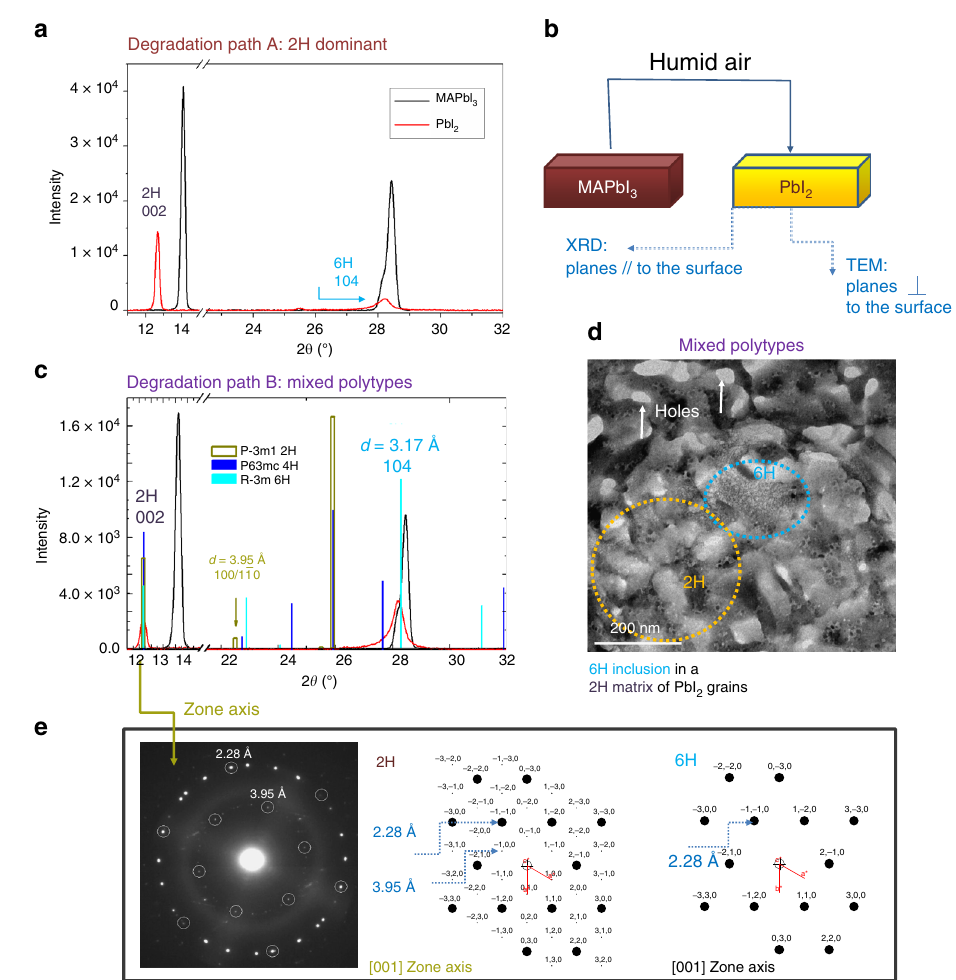
Fig. 6 Large area statistics by XRD on PbI 2 after full in air degradation of MAPbI 3 layers deposited on glass. a – c 2 θ – Ω symmetric X-ray diffraction patterns of fresh MAPbI 3 (black curves) layers fully converted into PbI 2 (red curves) under humid air conditions. In the statistics, the two degradation paths (A and B) represent possible scenarios for sample aged in air. Path A is the more frequently encountered. Path B is less frequent and represents a bridge toward the TEM-induced degradation. The vertical bars in c , that can be equally used for interpretation of the peaks in a , are markers for the different PbI 2 polymorphisms: light brown, blue and light blue lines stem for 2, 4, and 6H polytypes. Probed area = 0.2 cm 2 . b Schematic of the experiment that combines TEM and XRD analyses to study parallel and perpendicular planes with respect to the sample surface. d BF-TEM analyses of an in air degraded sample on the Cu-grid, showing the inclusion of a 6H-PbI 2 grain (light blue circle) morphologically and structurally different from the rest of the matrix (integration time = 4 s). The dominance of the 2H arrangement is drawn on the basis of the speci fi c spot at 3.95 angstrom in the EDPs reported in e wherein simulations discriminate between apparently similar 6 and 2H hexagonal patterns. In d holes are empty spaces left after volume contraction in the transition from MAPbI 3 to PbI 2 ( Δ V / V ~50%); the yellow circle highlights typical 2H-PbI 2 sliced grains. 2H and 6H-PbI 2 grains are indeed